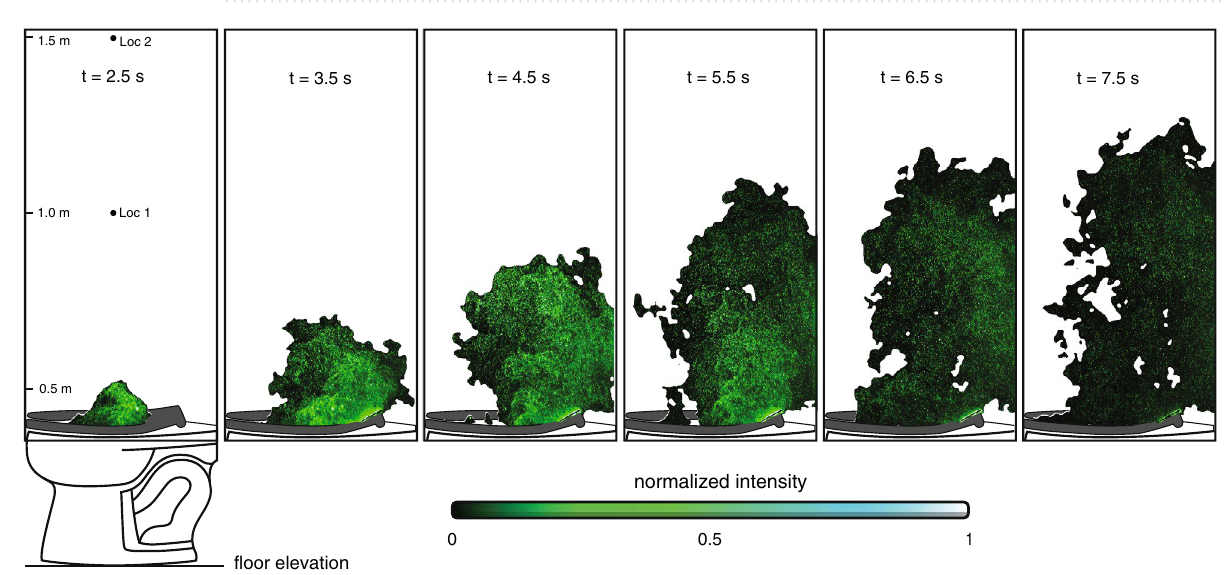
Figure 3. Spatial distribution and growth of aerosol plumes over time. Time sequence at 1 s intervals of flush- induced instantaneous aerosol plumes showing rapid and persistent growth. Each panel displays the intensity of imaged particles (green colormap) and computed plume envelopes (black regions), where the indicated times correspond to the flush sequence in Fig. 1D. The complex shape of the envelope boundary stems from the turbulent and chaotic flowfield induced by the toilet flush. The two locations “Loc 1” and “Loc 2” indicated in the first panel correspond to locations where optical particle measurements are taken, as shown in Fig. enhanced spatial resolution (250 µ m), each camera captures separate—but slightly overlapping—regions of the plume; the two images are stitched together to form a single 0.57 m wide × 1.23 m high image that reaches 1.59 m above the floor. To map the spatial evolution of the flush-induced aerosol plume (Fig. 3), we use an intensity thresholding technique to compute plume envelopes at different times in the flush sequence, where the indicated times cor- respond to the flush cycle in Fig. 1D. The computed envelope (rendered in black) demarcates the boundary of the advancing front of aerosols. The intensity of imaged particles is rendered in green for visual consistency with the color photographs in Fig. 2. The plume is ejected upwards and rearwards towards the wall behind the toilet, with the highest concentration of particles occurring within jet-like structures in the interior region of the enve- lope. By t = 4.5 s, the plume impinges on the impermeable rear wall, impeding rearward motion and enhancing the vertical motion. The plume motion is chaotic and turbulent, as exhibited by the complex and fractal nature